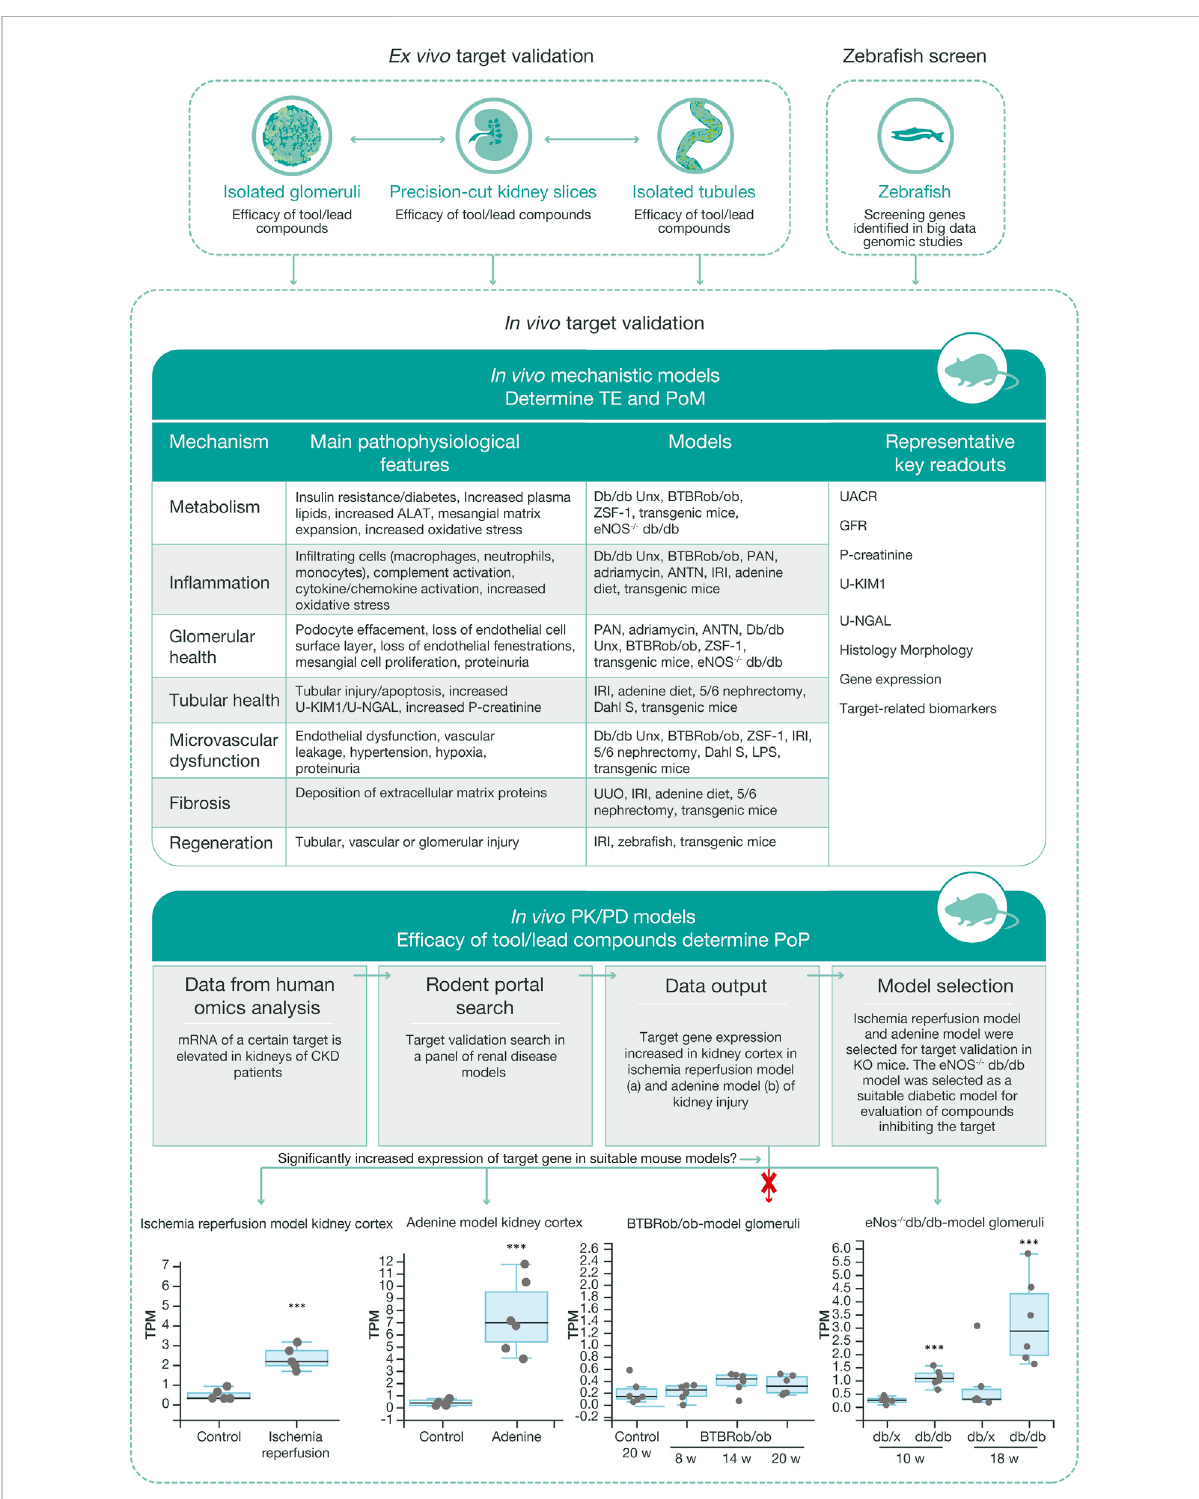
FIGURE 5 Work fl ow for in vivo target validation and compound testing. Ex vivo models are chosen to validate genes of interest and assess the ef fi cacy of compounds targeting these gene products, based on their cellular expression and target engagement, respectively. Data from the ex vivo experimentsguidethedesignofmechanisticandPKPD invivo studiesthatgeneratedataregardingtargetengagementandproofofmechanism,and on exposure and proof of principle, respectively. Various mechanistic models are used to validate targets and measure ef fi cacy of test